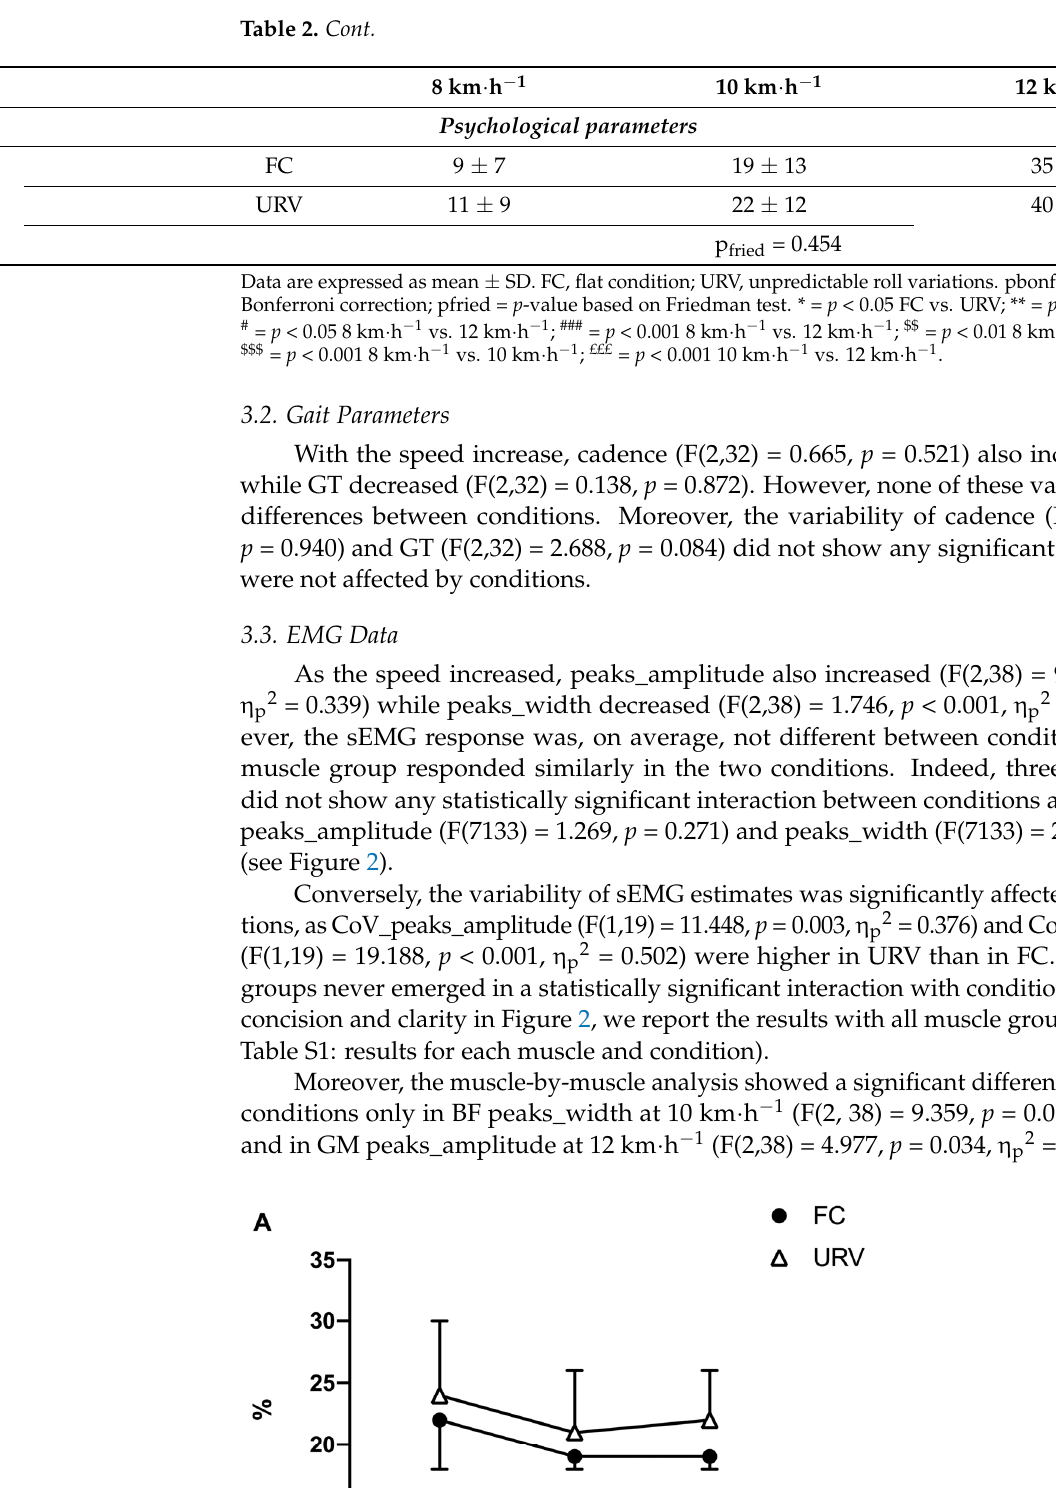
Figure 2. The coefficients of variation of peaks amplitude ( A ) and peaks width ( B ) for FC and URV conditions. Conversely, the variability of sEMG estimates was significantly affected by the con- ditions, as CoV_peaks_amplitude (F(1,19) = 11.448, p = 0.003, η p2 = 0.376) and CoV_peaks_width (F(1,19) = 19.188, p < 0.001, η p2 = 0.502) were higher in URV than in FC. As the muscle groups never emerged in a statistically significant interaction with condi- tions or speed, for concision and clarity in Figure 2, we report the results with all muscle groups merged (see Table S1: results for each muscle and condition). Moreover, the muscle-by-muscle analysis showed a significant difference between two conditions only in BF peaks_width at 10 km·h − 1 (F(2, 38) = 9.359, p = 0.002, η p2 = 0.330) and in GM peaks_amplitude at 12 km·h − 1 (F(2,38) = 4.977, p = 0.034, η p2 = 0.208). 3.4. Psychological Parameters Significant differences were not observed between experimental conditions (FC and URV) for the RPE values (see Table 2). 4. Discussion The transversally inclined surface treadmill can represent a novel way of training that simulates variable terrain when outdoor-specific training is not a feasible option. Pre- vious studies demonstrated how cardiopulmonary responses vary on “irregular surfaces” in the form of modified treadmills and natural surfaces [12,25,32,33]. Changes in mechan- ical work performed by muscles during walking and running on uneven terrain may ex- plain nearly half of the increase in metabolic cost from the transition from smooth to